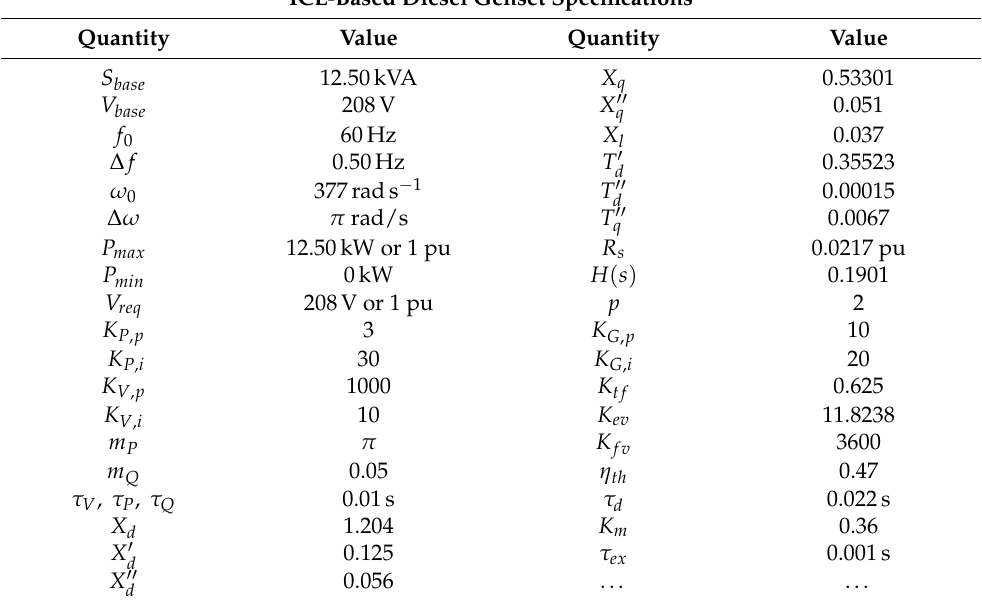
Table A4. ICE-based DGU (i.e., diesel genset)